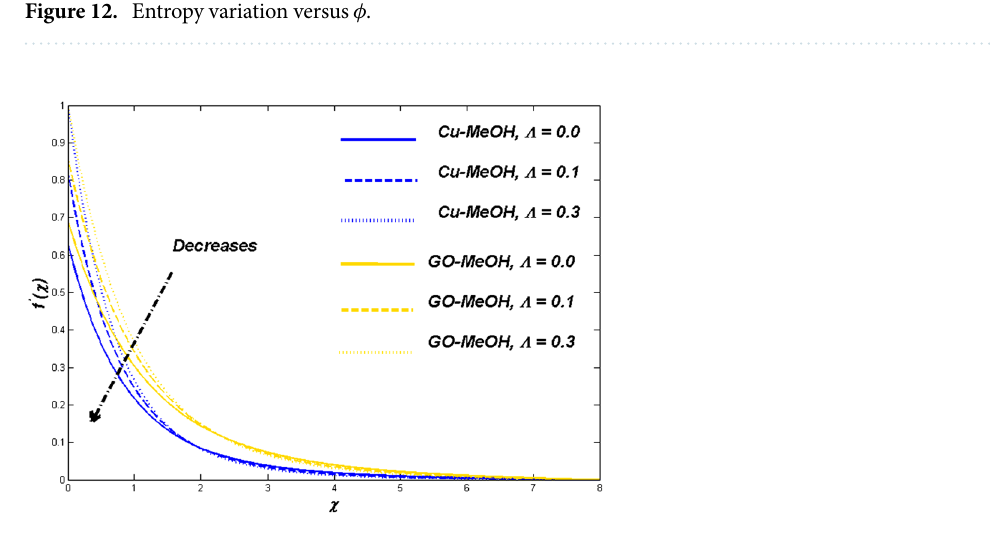
Figure 13. Velocity variation versus (cid:31)